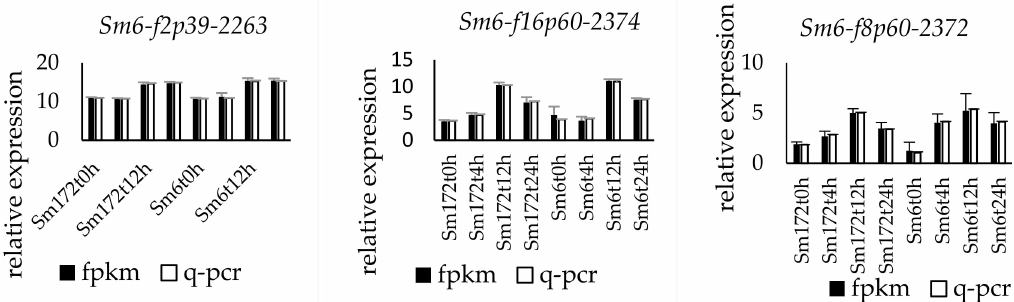
Figure 2. Expression profiles of 9 key DEGs in two poplar cultivars. Note: Sm172 stands for willow 172; Sm6 stands for Luliu